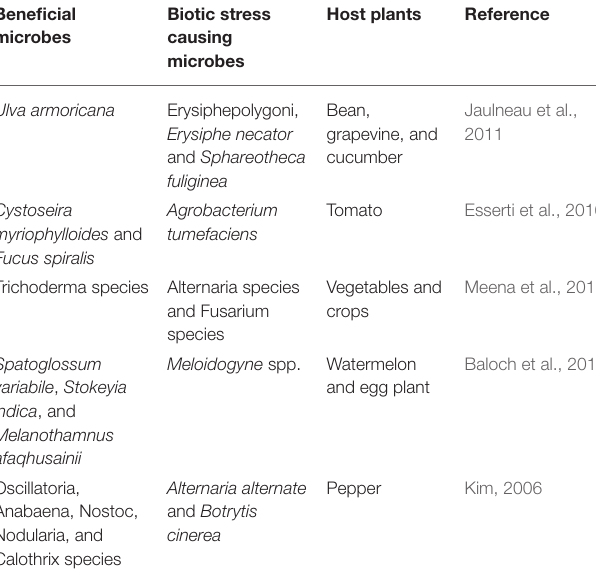
TABLE 3 | Role of beneficial microbe in plant